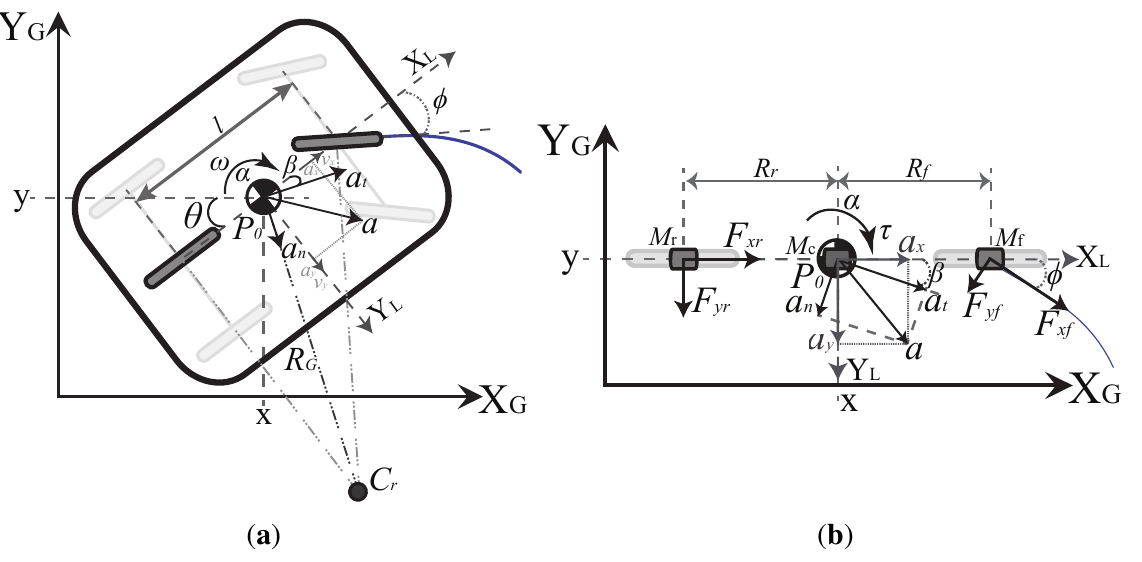
Figure 2. Ackermann steering mobile robot. ( a ) Kinematics; ( b )